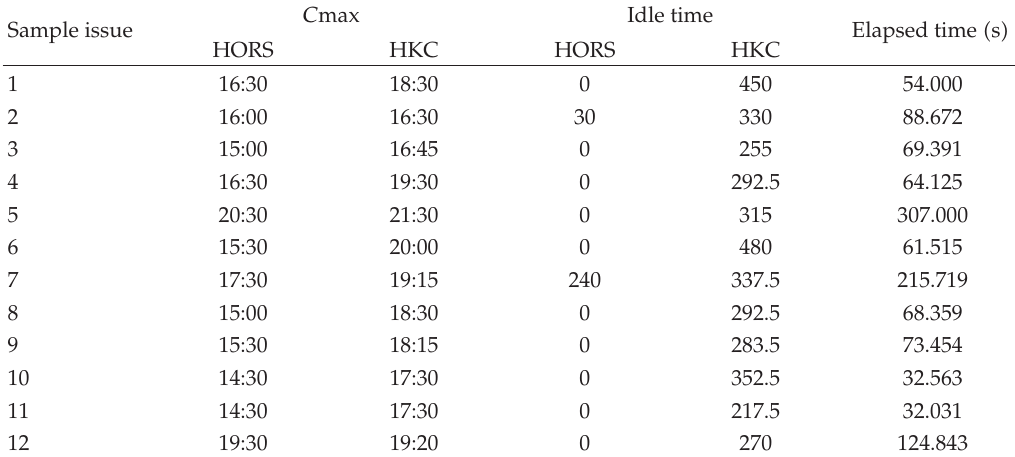
Table 2: Evaluation result of proposed model (cid:2) HORS (cid:3)